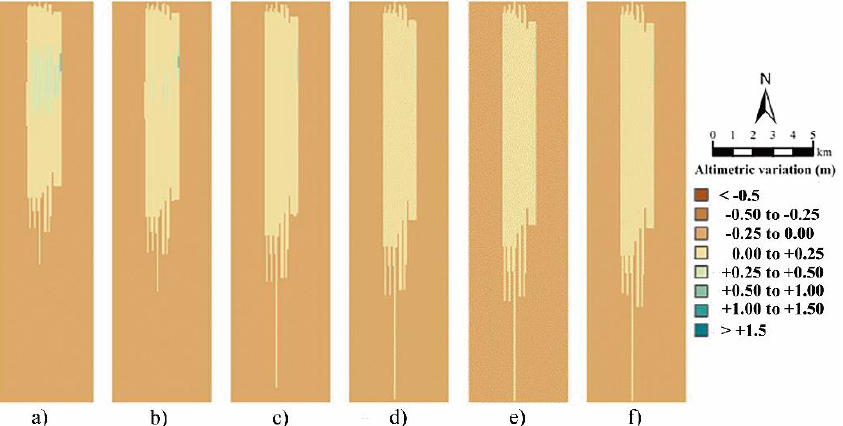
Figure 8. Beach nourishment impact on morphology after 5 years of simulation (H = 4 m; Ext/Ext): ( a ) θ = 60° ; ( b ) θ = 65° ; ( c ) θ = 70° ; ( d ) θ = 75°; ( e ) θ = 80°; ( f ) θ = 85° .